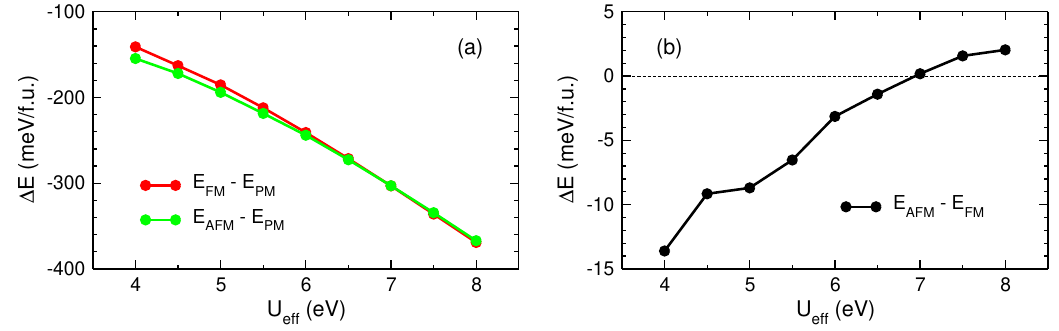
− E − E (red), E FM PM AFM PM